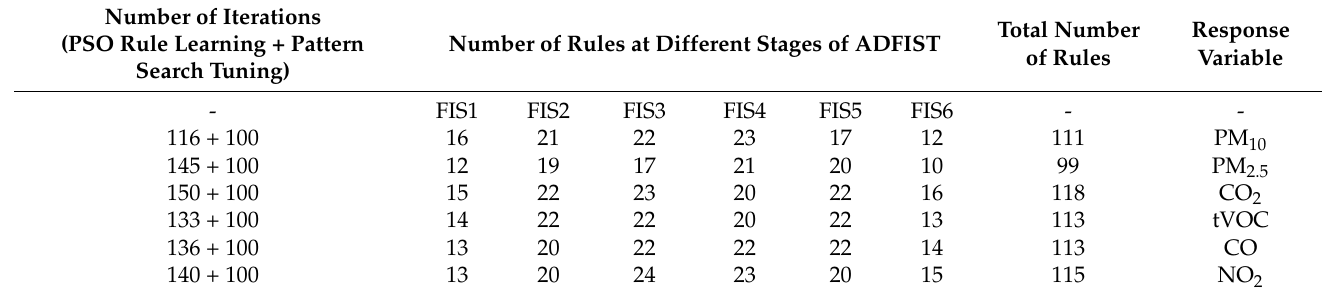
Table 4. Adaptive knowledge base of proposed ADFIST